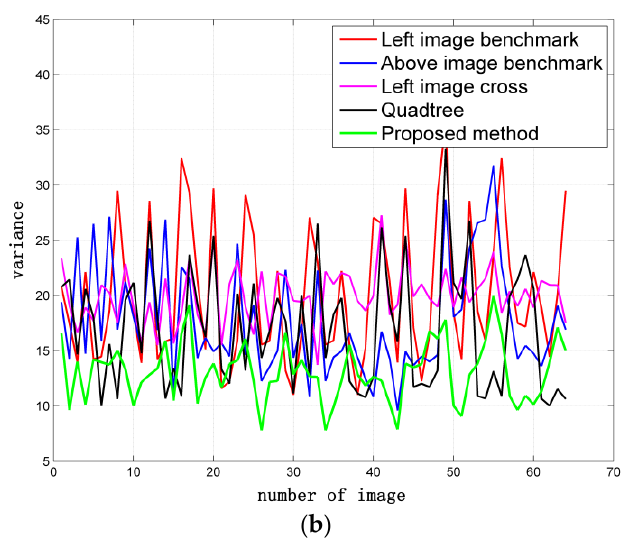
Figure 9. Distribution curve of the mean value and standard deviation of each sub-block image: ( a ) distribution curve of the mean value of each sub-block image; ( b ) distribution curve of the standard deviation of each sub-block image.